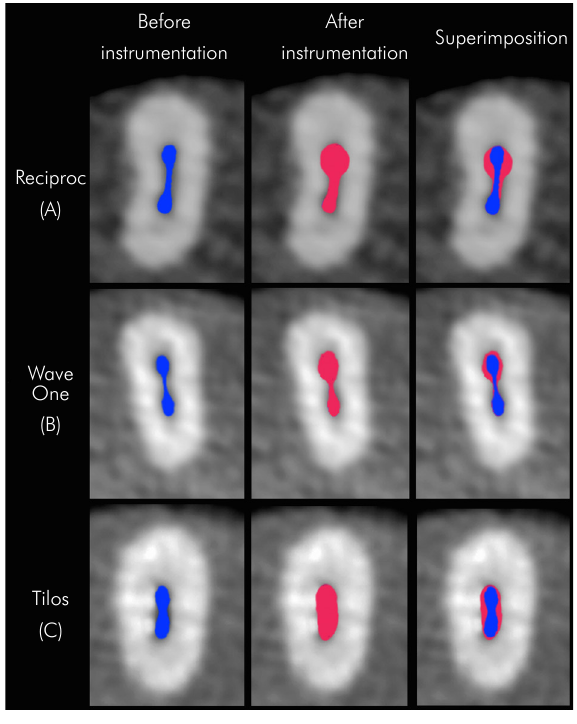
Figure 1. Comparative images of the middle thirds of the mandibular incisors before and after instrumentation and their superposition. The quality analysis of the preparation pattern in the middle thirds of the lower incisors showed that Reciproc and WaveOne systems (A and B, respectively) provided a more roun- ded preparation, incompatible with the original canals, whereas the Tilos (C) system resulted in a more uniform preparation around the perimeter of the root canal, in accordance with its